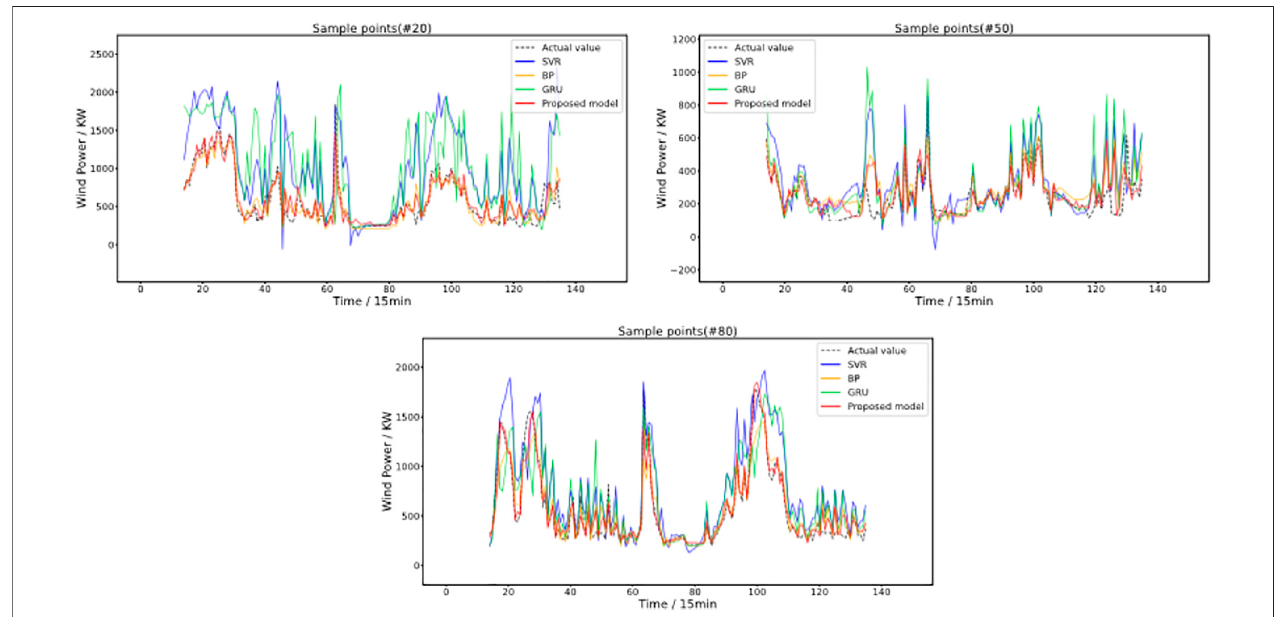
FIGURE 5 | Power prediction results of different models ’ wind turbines #20, #50, and #80.